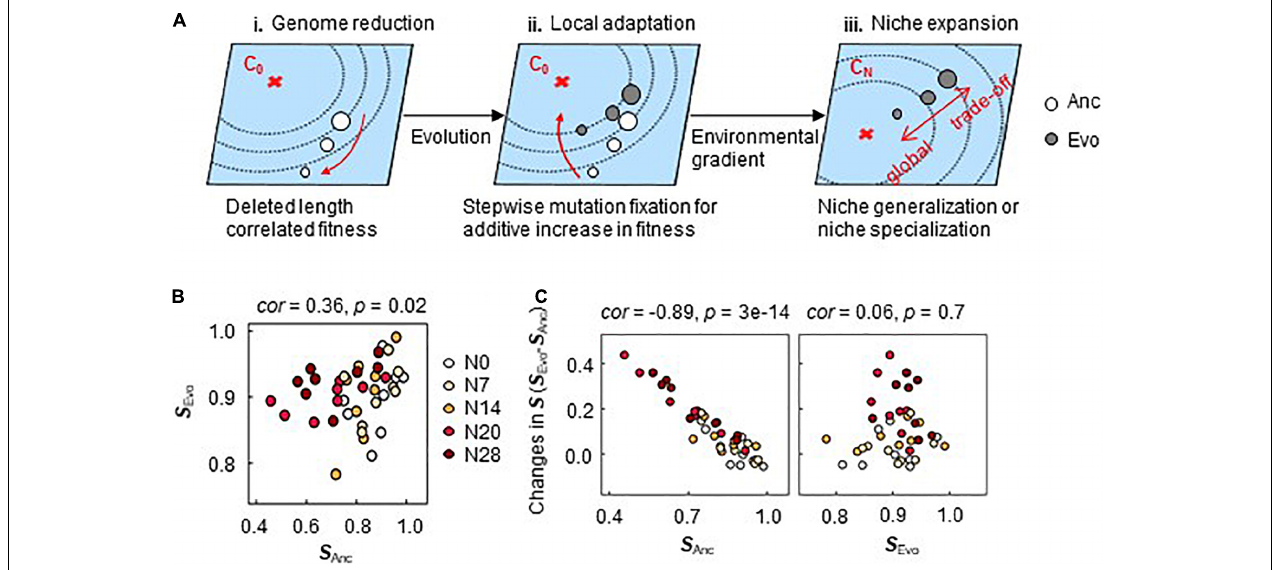
FIGURE 7 | Mechanism for pre-adaptation. (A) Illustration of fitness landscape analysis. The fitness landscapes in environment C 0 for the evolution and the alternative environments C N are shown as the planes in blue. The red cross and the contour lines indicate the fitness peak (maximum) and the fitness gradient, respectively. The open and closed circles indicate the ancestor and evolved genomes, respectively. The size of the circles indicates the genome size. (B) Correlated S of Ancs and Evos. The color variation from white to dark red represents the five different genomes of N0 ∼ N28. The niche spaces of Ancs and Evos are named S Anc and S Evo , respectively. (C) Relationships of S Anc and S Evo to the changes in S . The changes in S caused by the evolution are plotted against S Anc and S Evo in the left and right panels, respectively. The Spearman rank correlation coefficients and statistical significance are indicated.